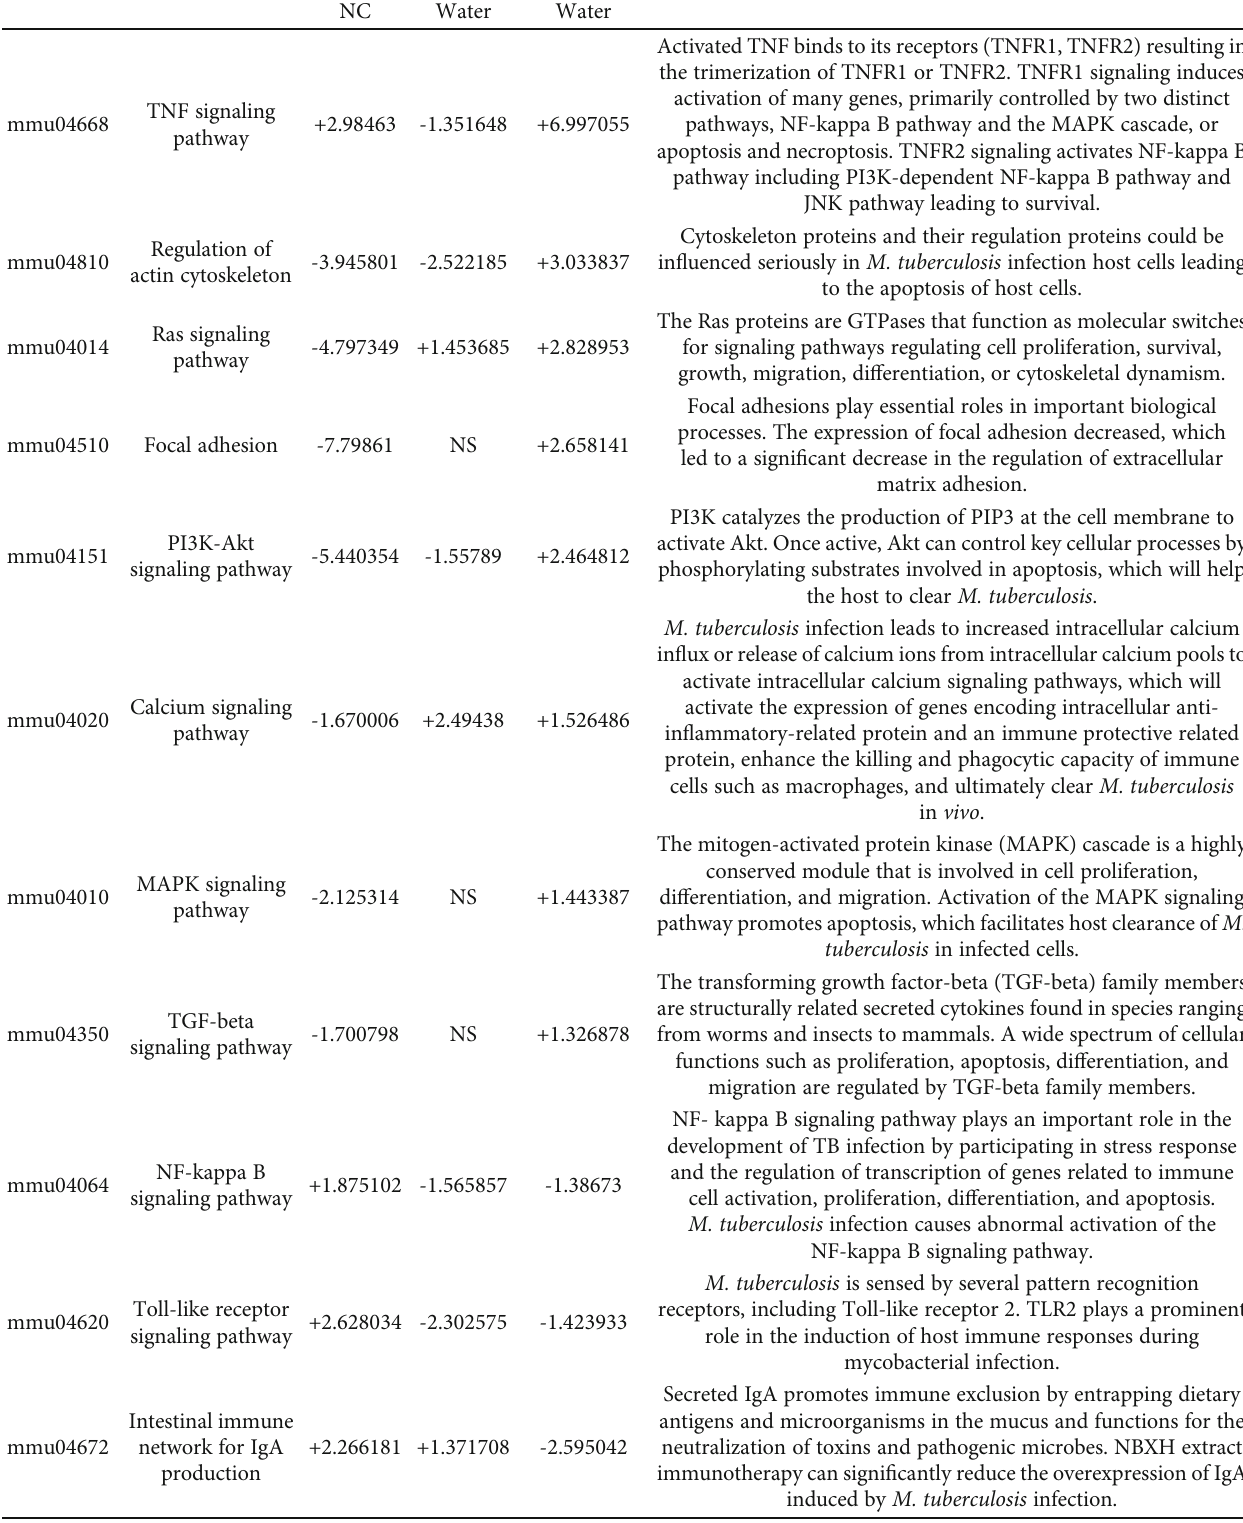
Table 5: Signi fi cantly upregulated or downregulated signaling pathways associated with immunity and in fl ammation. Pathway